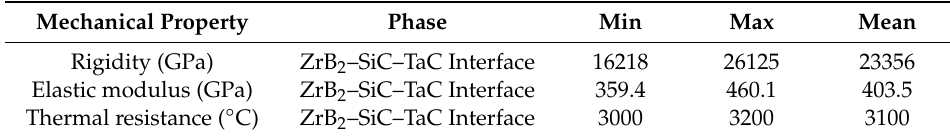
Table 2. Mechanical and thermal properties of the material interface.